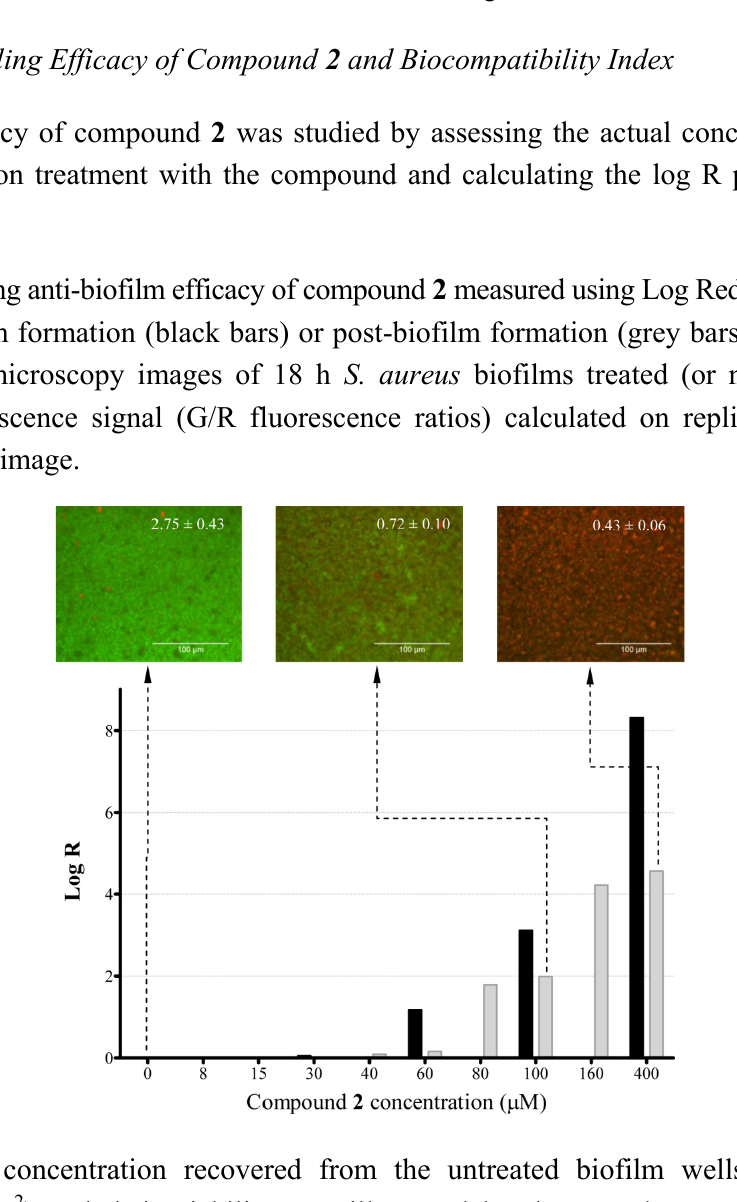
Table 3. Biocompatibility index (BI) for compound 2 . Three different values were calculated based on the cytotoxicity results registered in three different cell lines (LC and the concentration of compound 2 causing a 3-log reduction in the post-exposure anti-biofilm assay (140 μ M, corresponding to 42.1 mg/L).